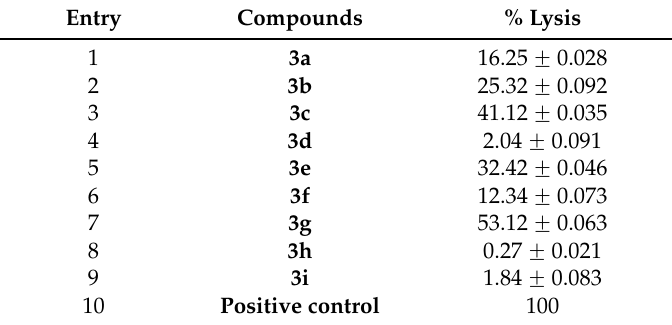
The results are average ± S.D of triplicate experiments, p < 0.05. Streptokinase was used as the control standard drug.